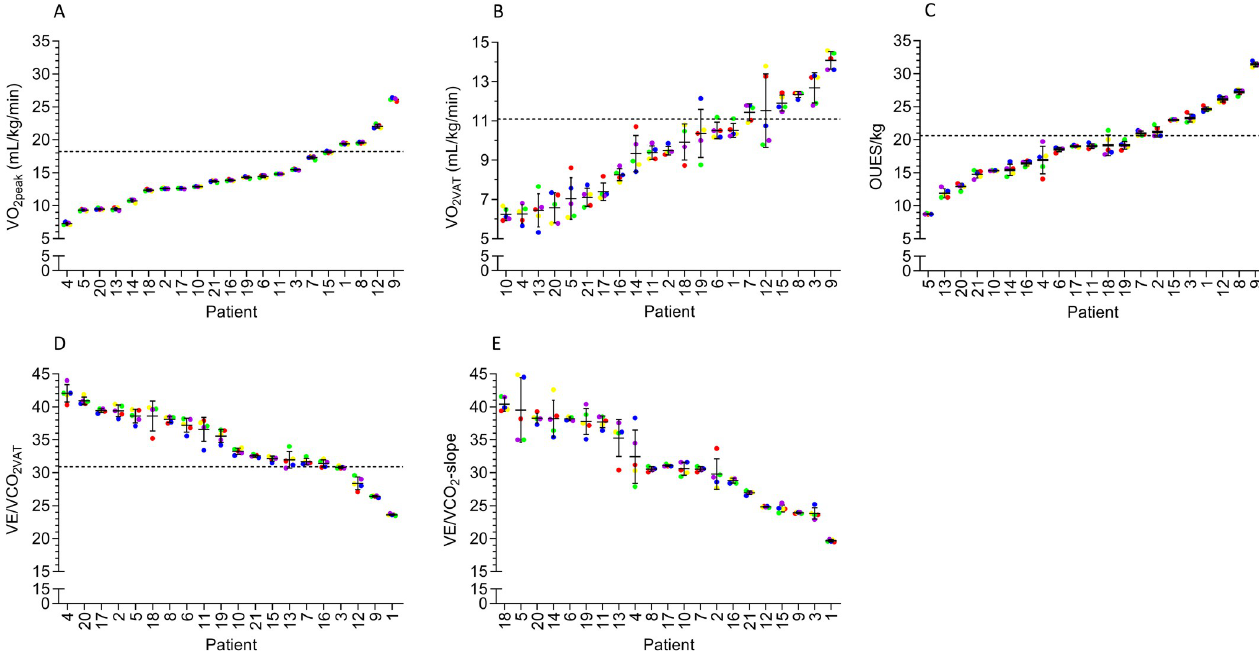
Fig 2. Variation in the observed values of VO 2peak (graph A), VO 2VAT (graph B), OUES (graph C), VE/VCO 2VAT (graph D), and the VE/VCO 2 -slope (graph E) within individual patients. Dots represent individual numerical value with a unique color for each data-averaging interval throughout the graphs (red = 10 seconds; yellow = 20 seconds; green = 30 seconds; blue = 3 breaths; purple = 7 breaths). Error bars represent the mean values and 95% confidence intervals. Horizontal dotted lines represent known risk assessment thresholds defined as 18.2 mL/kg/min for VO 2peak (graph A), 11.1 mL/kg/min for VO 2VAT (graph B), < 20.6 for OUES (graph C), and > 30.9 for VE/VCO 2VAT (graph D). Note that individual values of patients often cross the risk threshold (dotted horizontal line). These patients might have a different risk estimation depending on the data-averaging interval. Abbreviations: OUES = oxygen uptake efficiency slope; VE/VCO 2 -slope = the slope of the relationship between the minute ventilation and carbon dioxide production; VE/VCO 2VAT = ventilatory equivalent for carbon dioxide at the ventilatory anaerobic threshold; VO 2peak = oxygen uptake at peak exercise; VO 2VAT = oxygen uptake at the ventilatory anaerobic threshold.